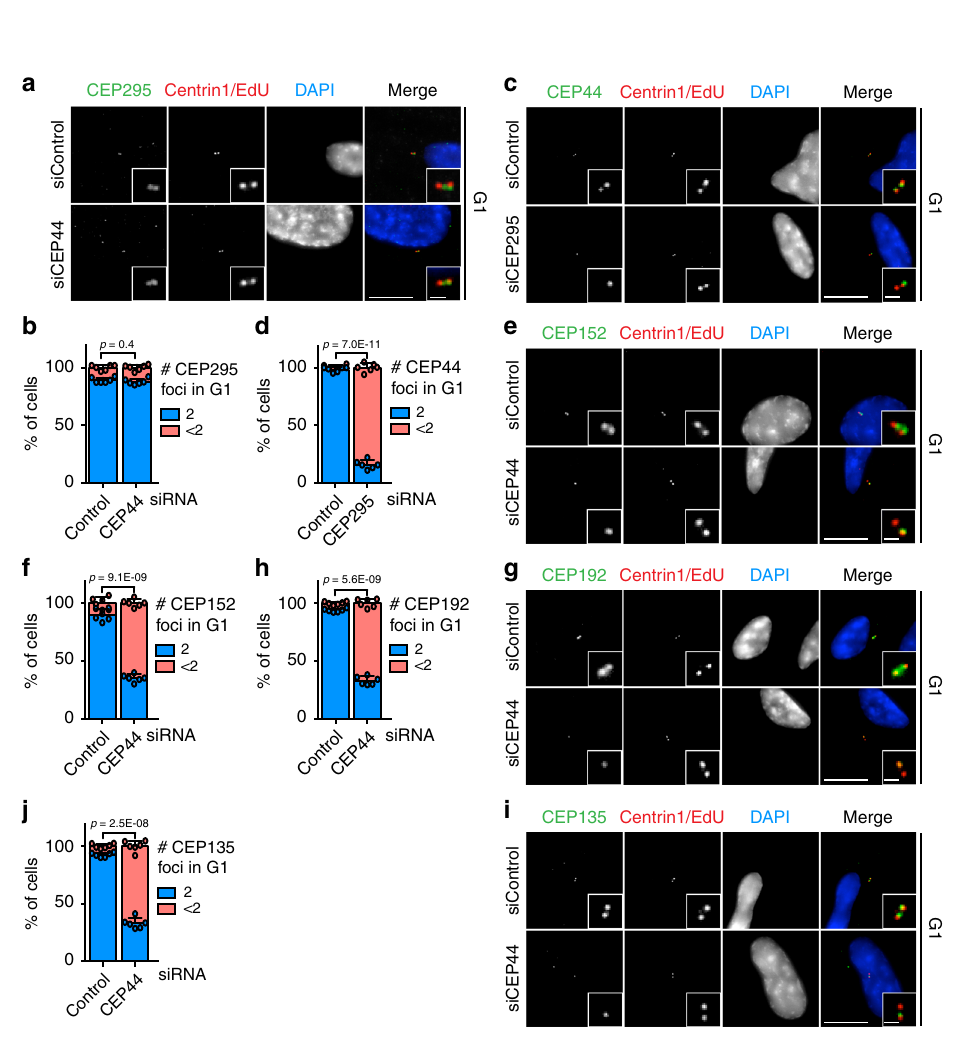
Fig. 2 CEP44, downstream of CEP295, in fl uences the conversion mechanism. a CEP295 did not delocalise from the centrioles in G1 cells (Cenp-F in Supplementary Fig. 3a) upon CEP44 siRNA depletion (10.9 ± 2.3% of cells with <2 CEP295 foci in siControl cells vs. 12.1 ± 2.5% in siCEP44 sample). b Quanti fi cation of a . c CEP44 strongly delocalised from the daughter centrosome in the absence of CEP295. G1 cells (Cenp-F negative in Supplementary Fig. 3c) were analysed. d Quanti fi cation of c . In siCEP295 84.0 ± 3.7% of the cells had <2 CEP44 foci. e CEP44-less daughter centrosomes lacked CEP152 ( f , 64.9± 3.2% of G1 cells vs. 10.1 ± 5.1% in control; Cenp-F in Supplementary Fig. 3i, left column), g CEP192 ( h , 67.1 ± 3.6% of G1 cells; Cenp-F in Supplementary Fig. 3i, middle column) and i CEP135 ( j , 66.9 ± 4.6% of G1 cells; Cenp-F in Supplementary Fig. 3i, right column). ( a , c , e , g , i , scale bars: 10 μ m, magni fi cation scale bars: 1 μ m; b , d , f , h and j data are presented as mean ± s.d., all statistics were derived from two-tail unpaired t -test analysis of n